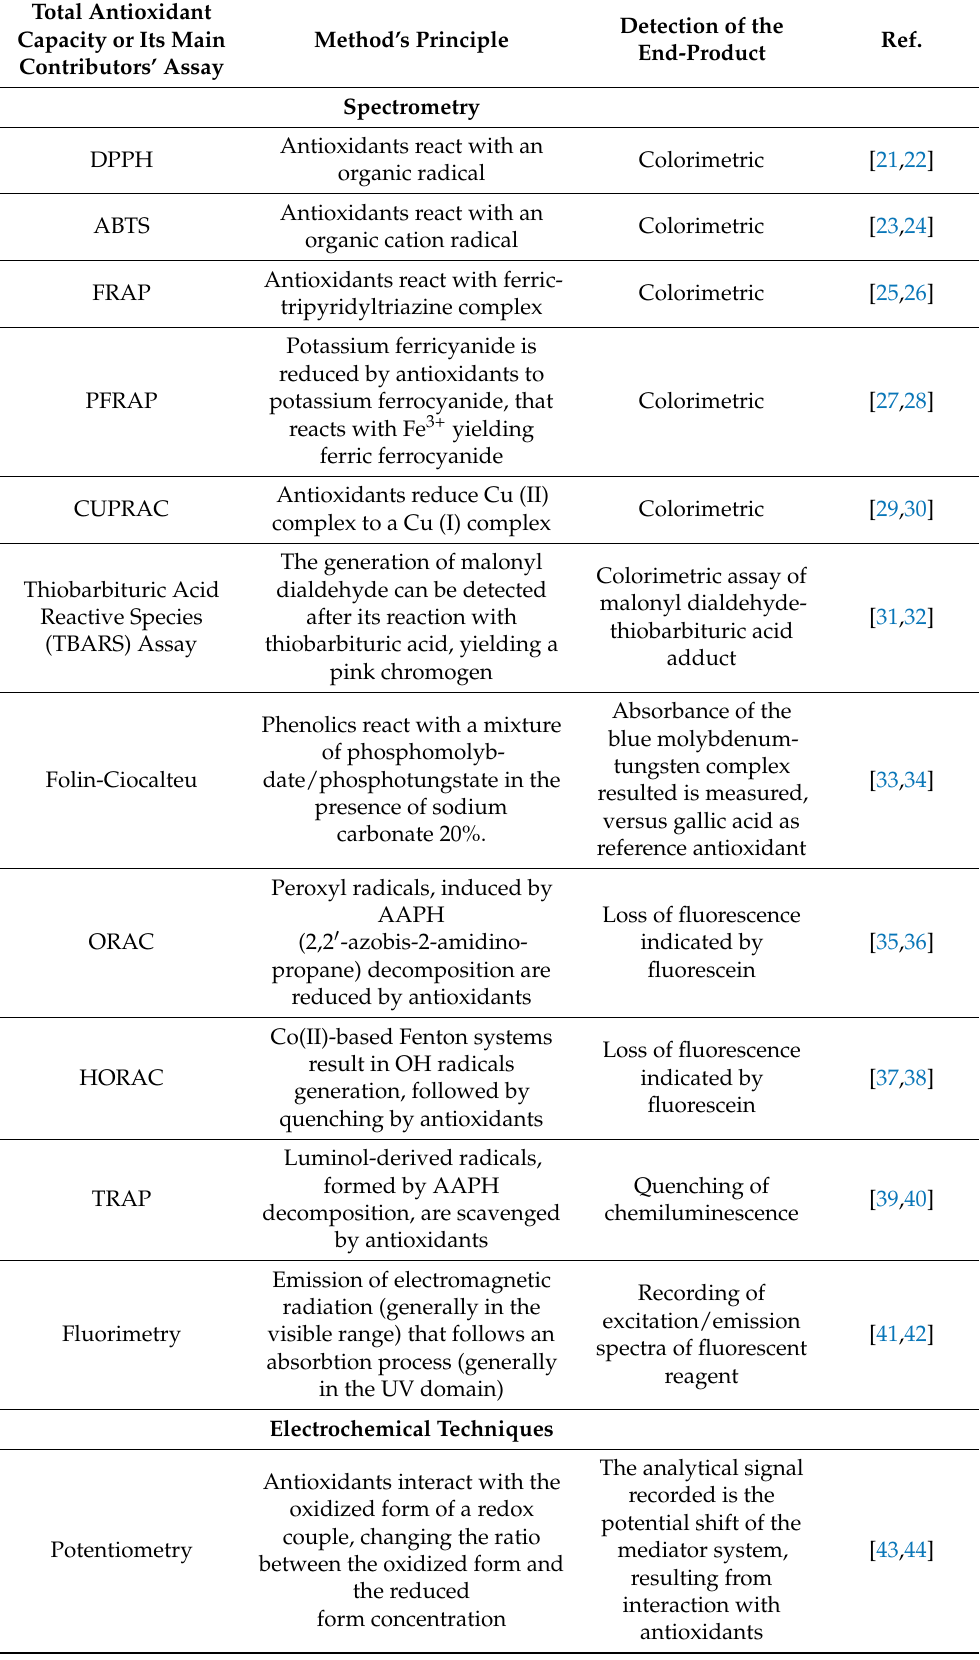
Table 1. The main analytical methods applied to antioxidant assay